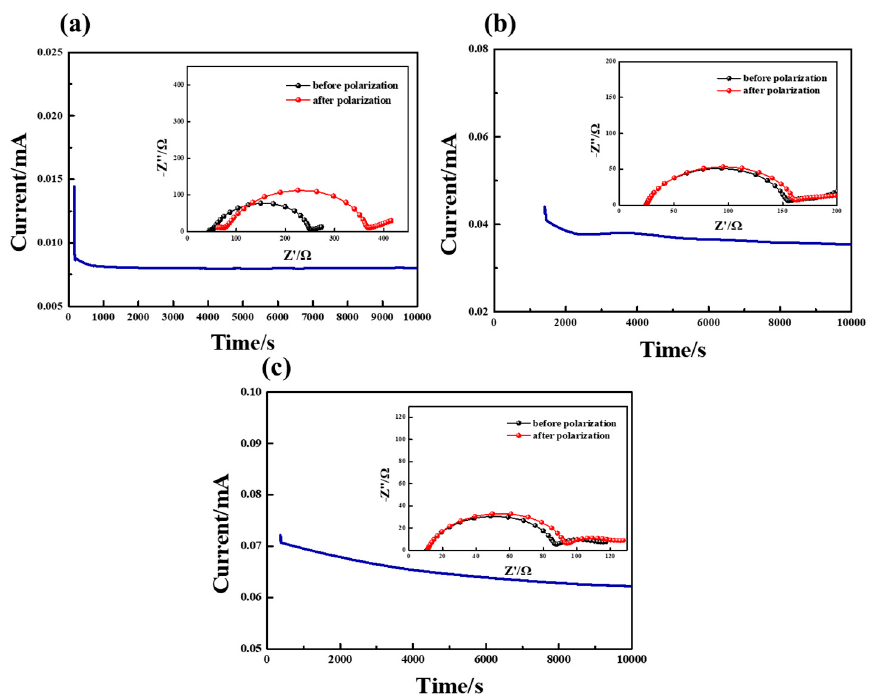
Figure 8. Current–time curves of DC polarization and Nyquist plots before and after polarization in different GPEs. ( a ) CS-g-PEG-120, ( b ) CS-g-PEG-240, ( c ) CS-g-PEG-480.